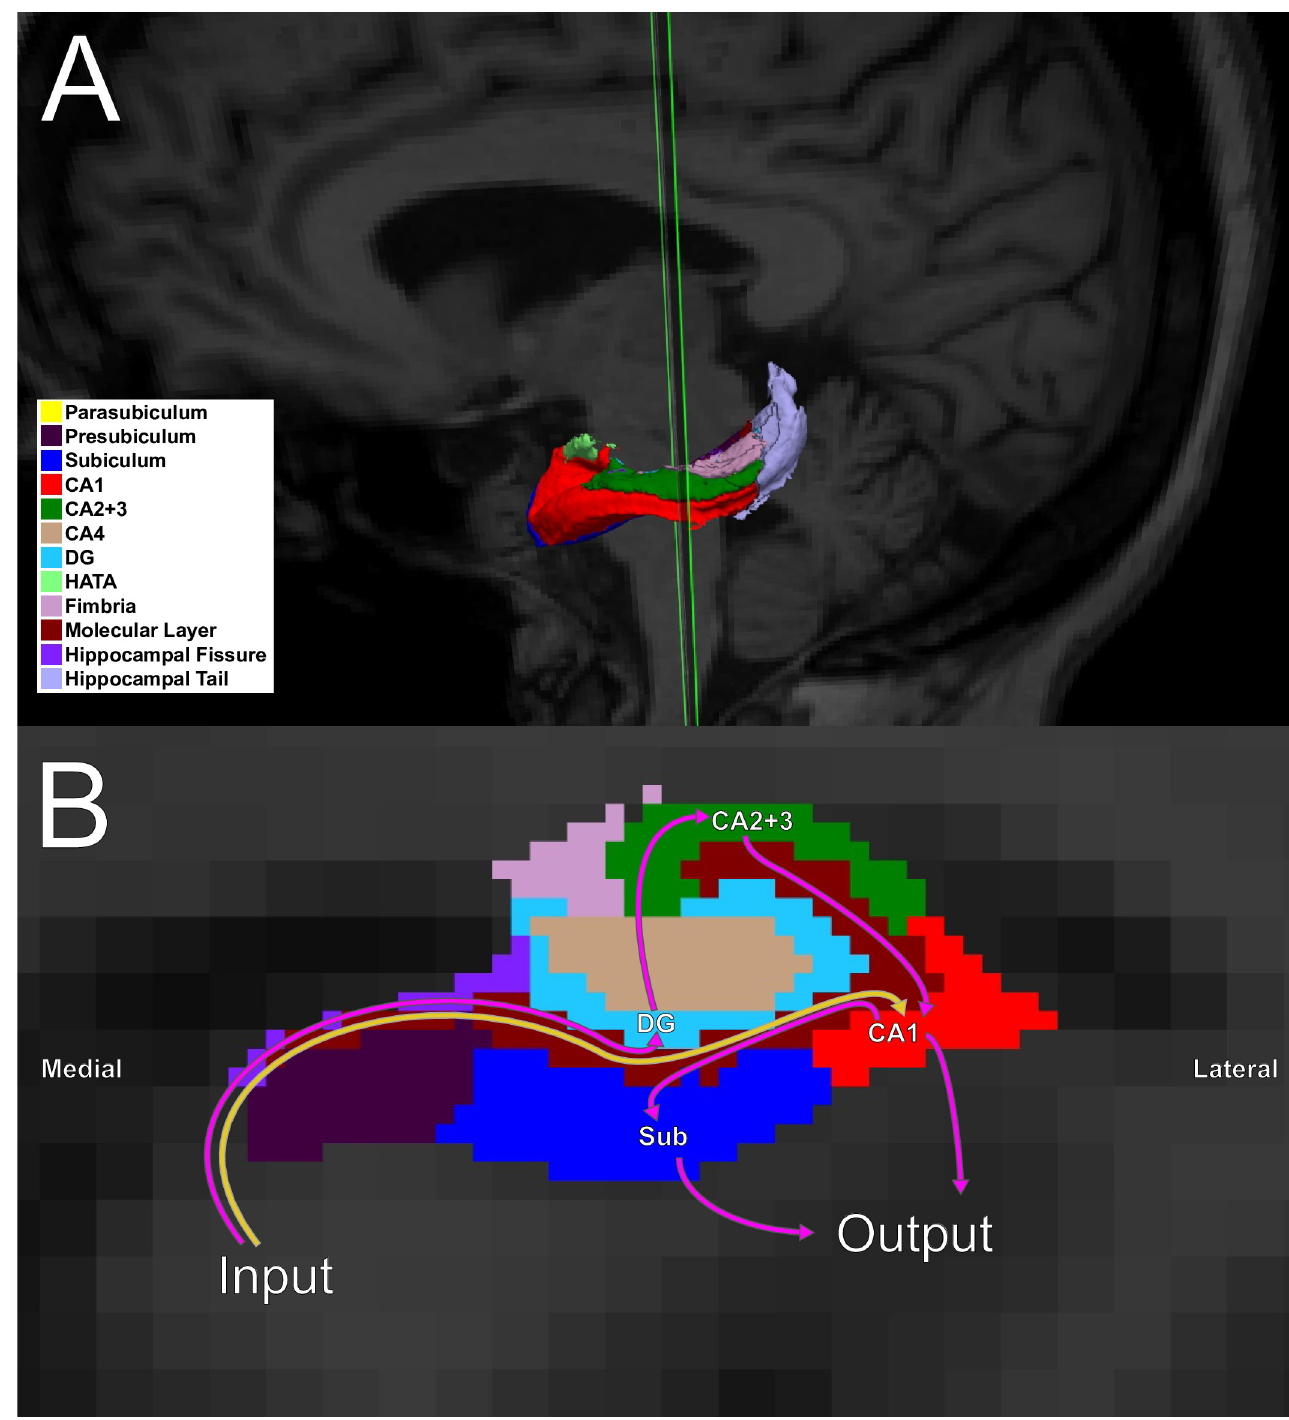
Fig 1. Hippocampal subfield segmentation using the procedure by Iglesias and colleagues [6]. A. This three-dimensional model of the left hippocampus depicts its segmentation into 12 subfields (although not all subfields are visible from the angle presented). B. This coronal section through the hippocampus illustrates subfields that are visible in the slice, and it shows the two major hippocampal neural pathways originating in the entorhinal cortex and as described in the text: The yellow arrow shows the direct circuit; the pink arrows indicate the trisynaptic circuit. Although the connection from CA1 to the subiculum is not explicitly part of the trisynaptic circuit, it is important as an output region, in addition to CA1. Abbreviations: CA1 = cornu ammonis 1; CA2+3 = cornu ammonis 2 and 3; CA4 = cornu ammonis 4; DG = dentate gyrus; HATA = hippocampal-amygdaloid transition area; Sub = subiculum.